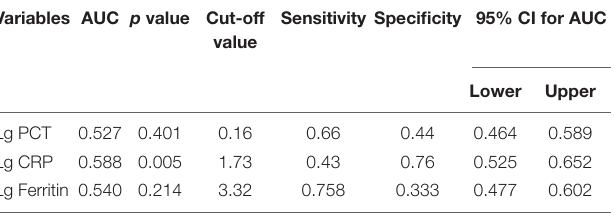
TABLE 5 | Predictive values of parameters for the bacterial infection of